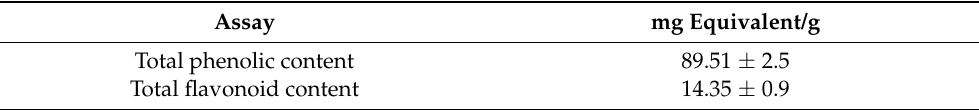
Table 4. The total polyphenol and flavonoid contents of A. nilagirica ethanol